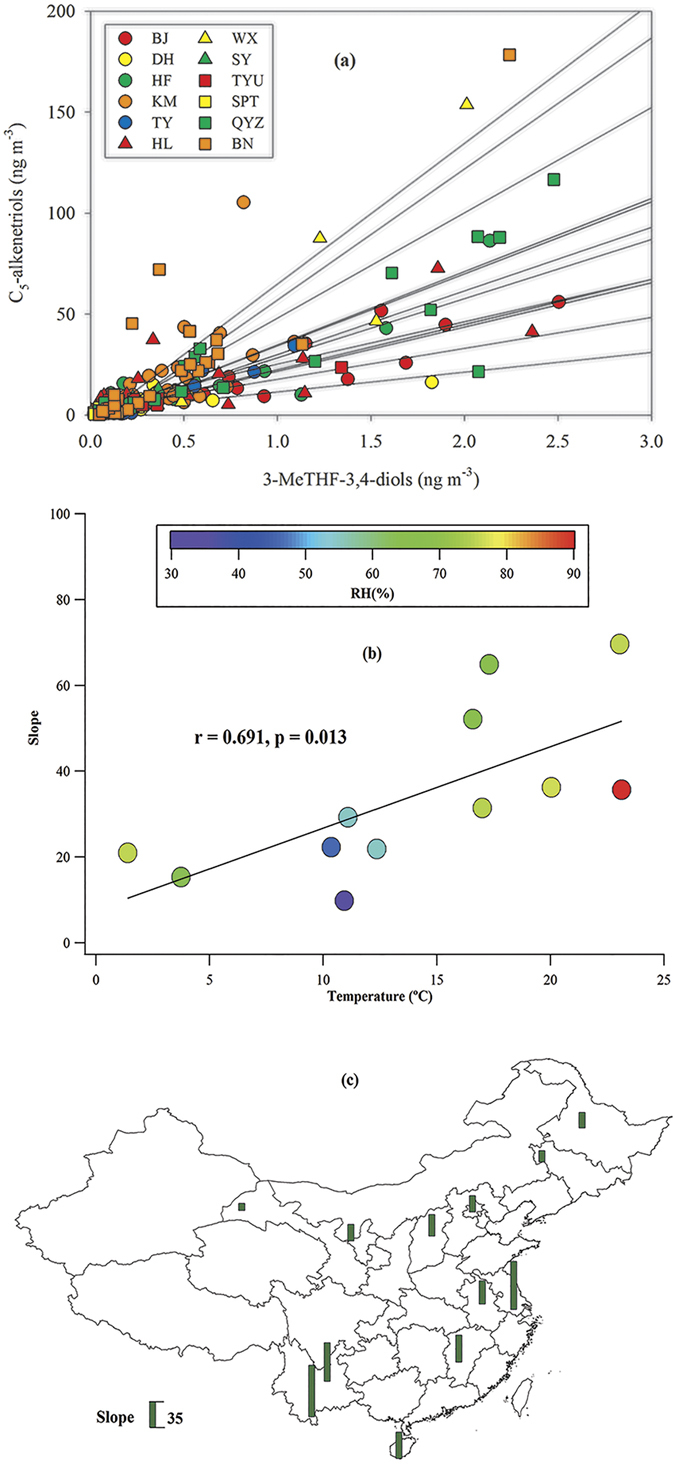
(a) Significant correlations between C5-alkenetriols and 3-MeTHF-3,4-diols at all sites (p < 0.01). Circle, triangle and square represent urban, sub-urban and rural sites, respectively. (b) Correlations of the slope (ΔC5-alkenetriols/Δ3-MeTHF-3,4-diols) with temperature and humidity. (c) Spatial distribution of the slope in China.